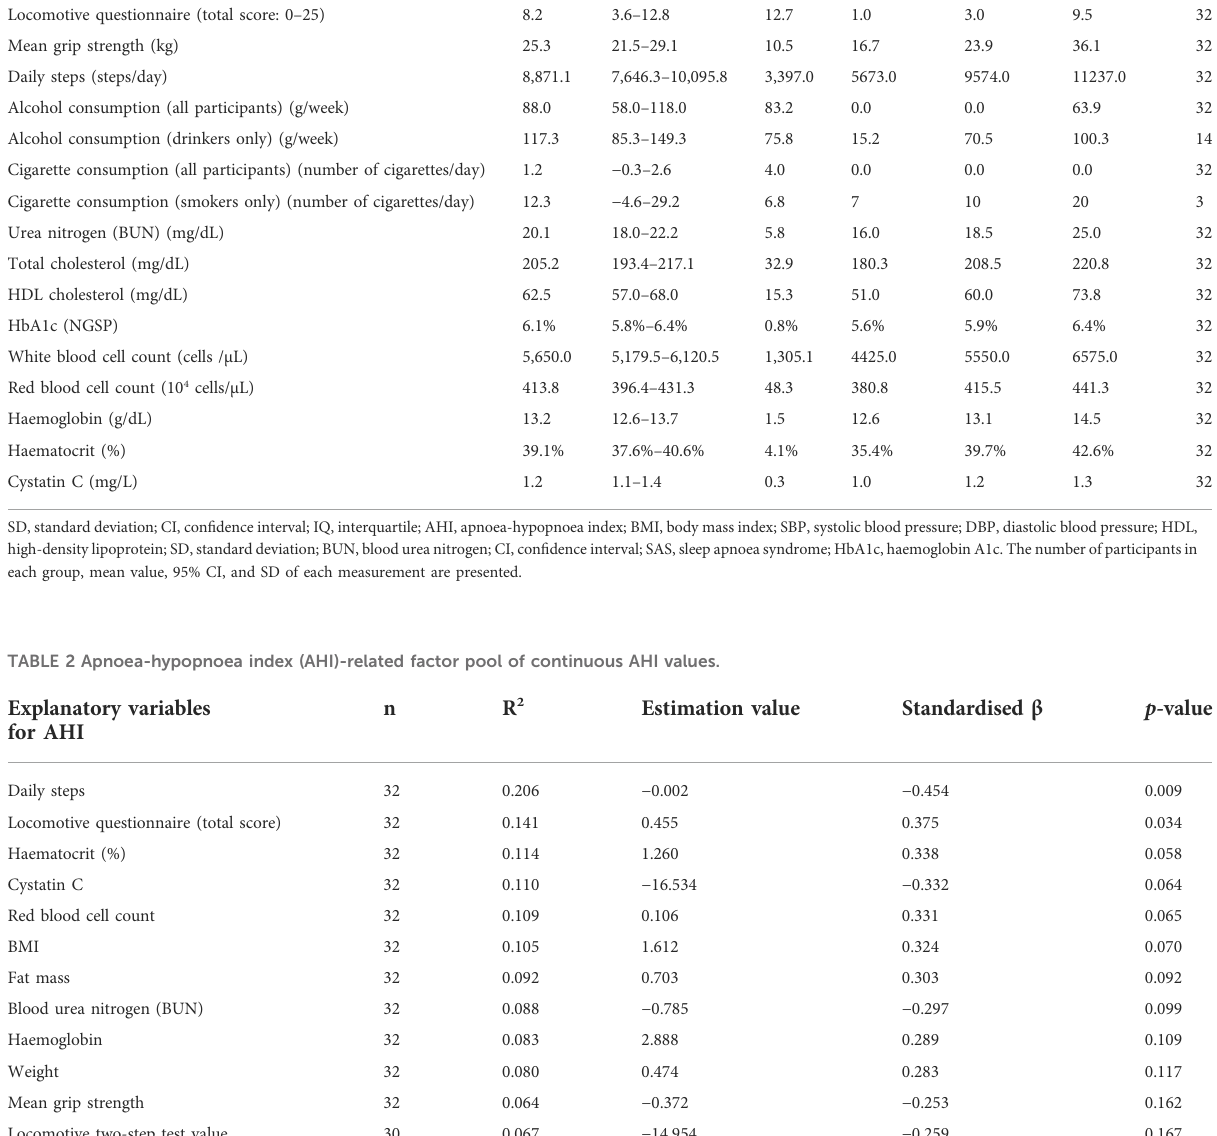
TABLE 1Representative dataset obtained by supra-multidimensionalsurveys of Japanese older adults residing in Yamanashi Prefecture (N = 32). The table shows a detailed breakdown of participants based on AHI severity. Parameter Mean 95% CI SD